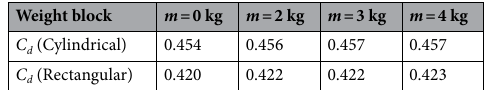
Table 3. H = 0.10 m, stable value of resistance coefficient.